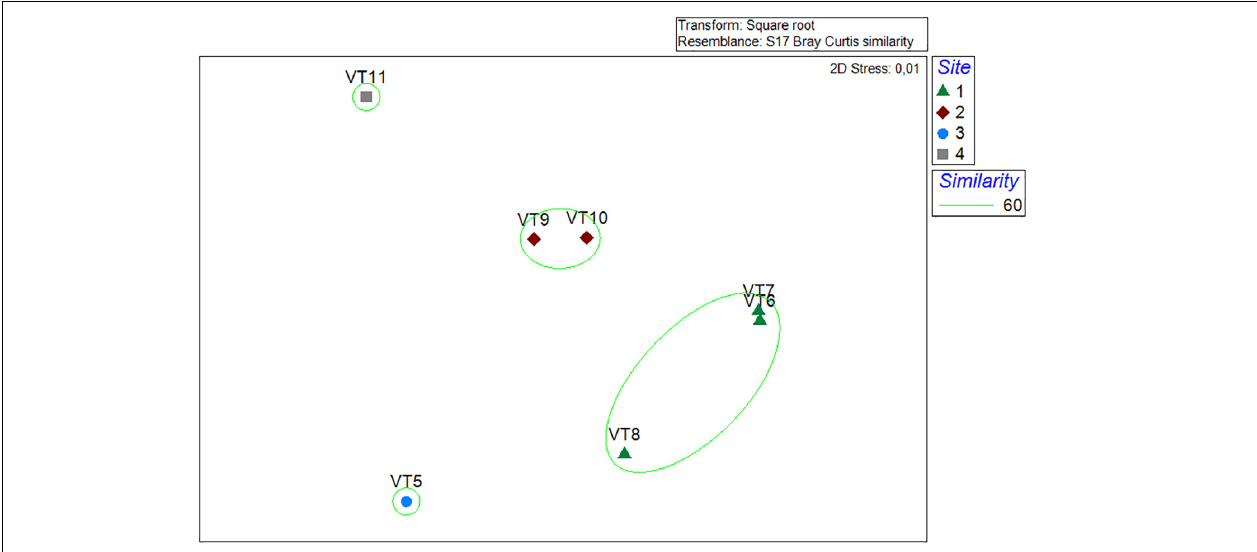
FIGURE 5 | Multidimensional scaling plot. Green circle represents 60% similarity. Site 1: VT6, 7, and 8. Site 2: VT8 and 9. Site 3: VT5. Site 4: